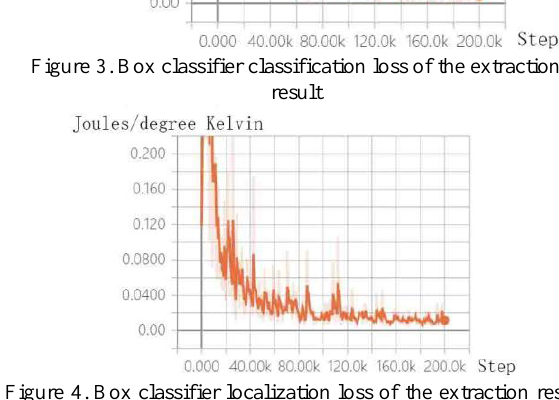
Figure 7. Global step time cost